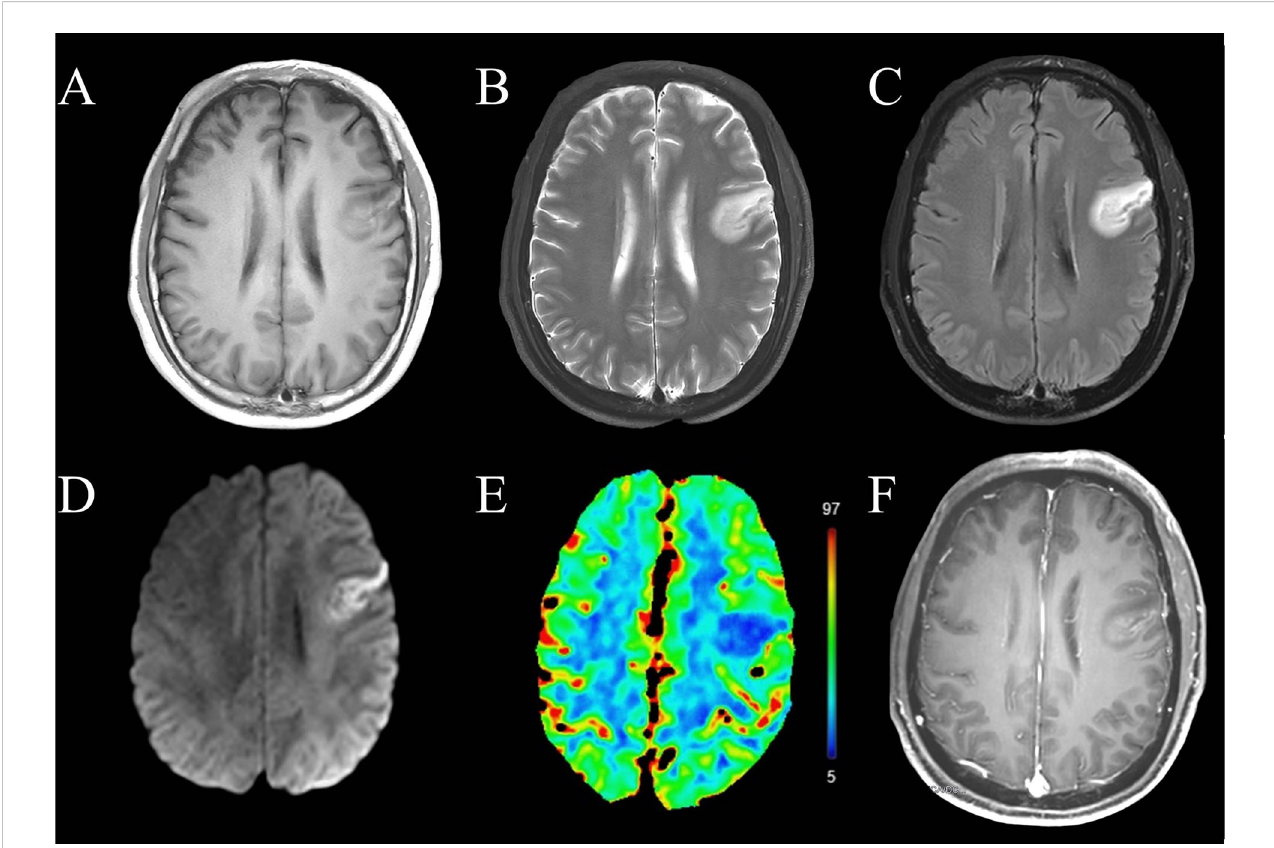
FIGURE 1 Magnetic resonance imaging of the brain before immunotherapy. The left frontal lobe showed abnormal (A) T1 hypointensity, (B) T2 hyperintensity, (C) hyperintensity on fl uid-attenuated inversion recovery imaging, (D) restricted diffusion and (E) decreased cerebral blood fl ow. (F) This lesion showed gyral enhancement involving the cortex and subcortical white